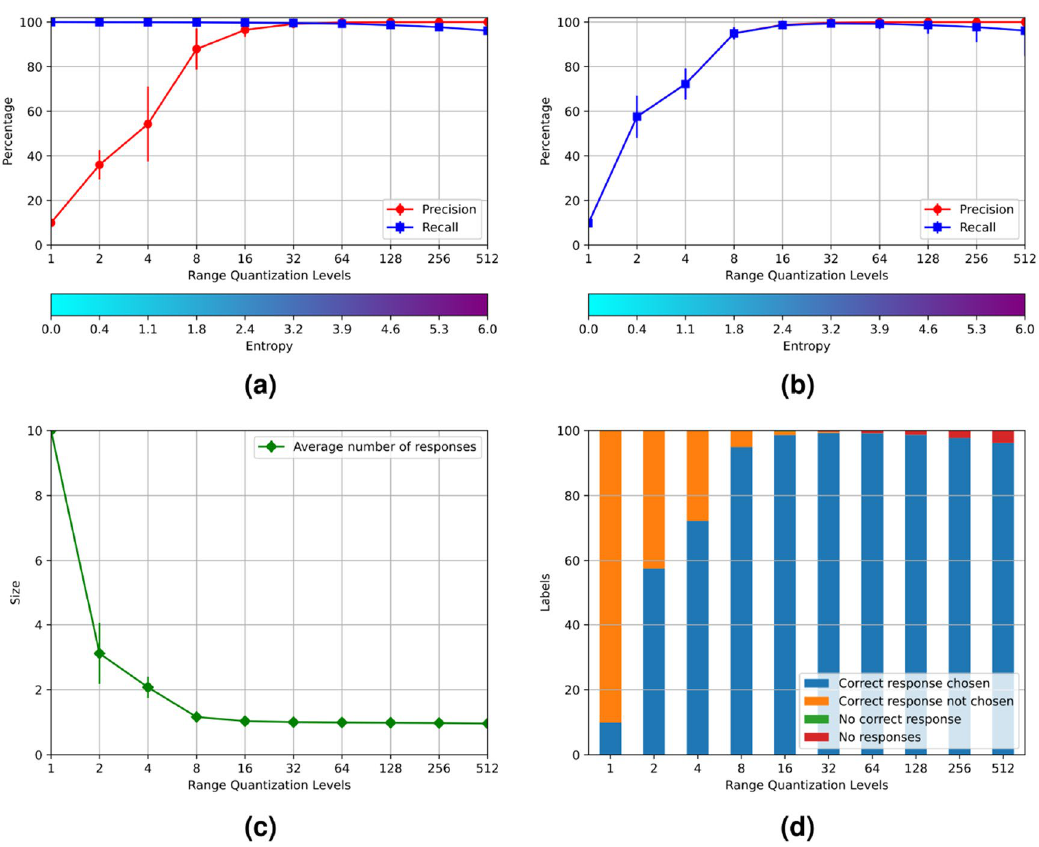
Figure 3. Results of experiment